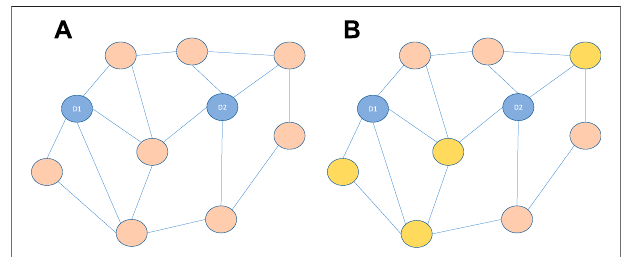
FIGURE 1 | (A) Blue represents known interactions with the input drugs (D1, D2), and orange represents drugs whose unknown interactions need to be predicted. (B) Search the whole network with different methods to fi nd the drugs mostsimilarto D1 and D2, which arerepresented by yellow drugs in the fi gure. Finally, the possibility of interaction between yellow drugs and input drugs was